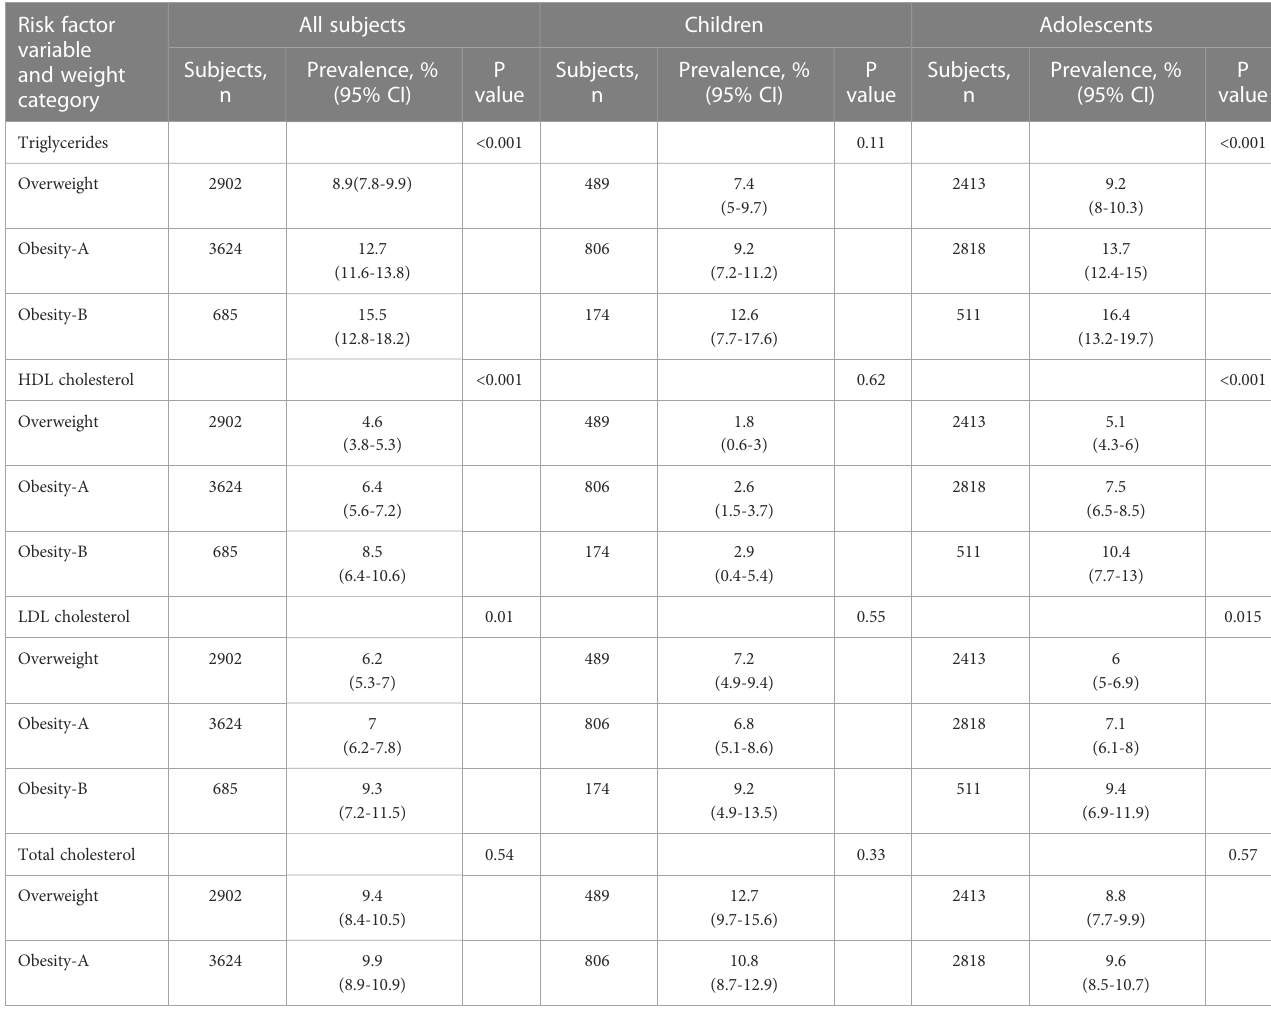
Table 4 shows a direct comparison of CMRFs between weight groups of children and adolescents in multivariable generalized linear models that adjusted for age and sex. Children and adolescents in the obesity-B group had greater odds for higher triglycerides, LDL cholesterol, and ALT and lower HDL cholesterol levels, as compared TABLE 3 Prevalence of comorbidities and abnormal values for cardiometabolic variables by weight among children and adolescents. Risk factor